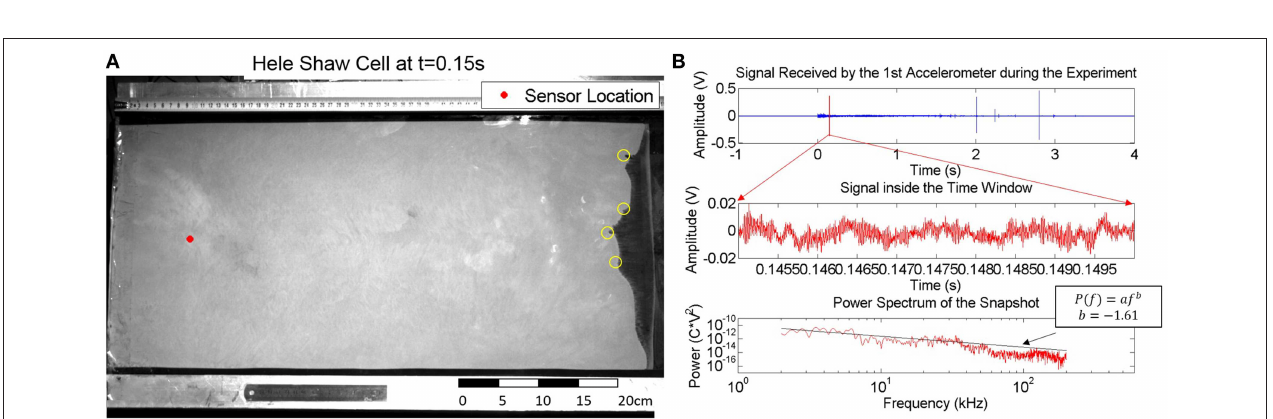
FIGURE 6 | Optical (A) and acoustic (B) experimental recordings just before channeling. Yellow circles on the left image shows the initiation points of the channeling. The red dot on the left image illustrates the sensor location where the signal on the right is recorded. Top Right panel: Acoustic signal recorded throughout the entire experiment. The red strip (time window of 0.005s) corresponds to the snapshot that the image (A) and power spectrum (Bottom Right) occurred